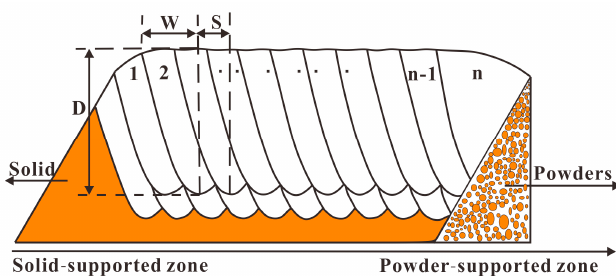
Figure 4. The definition of depth ( D ), half width ( W ), and hatch spacing ( S ) of molten pool,